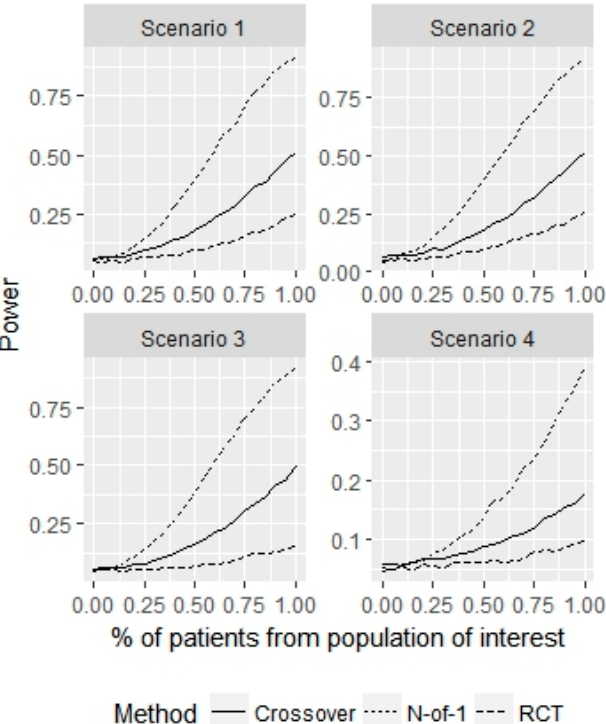
Figure 6. Simulation study for non-representative sample of size 30. This figure displays the power for the population of interest as a function of the proportion of patients sampled from this population.